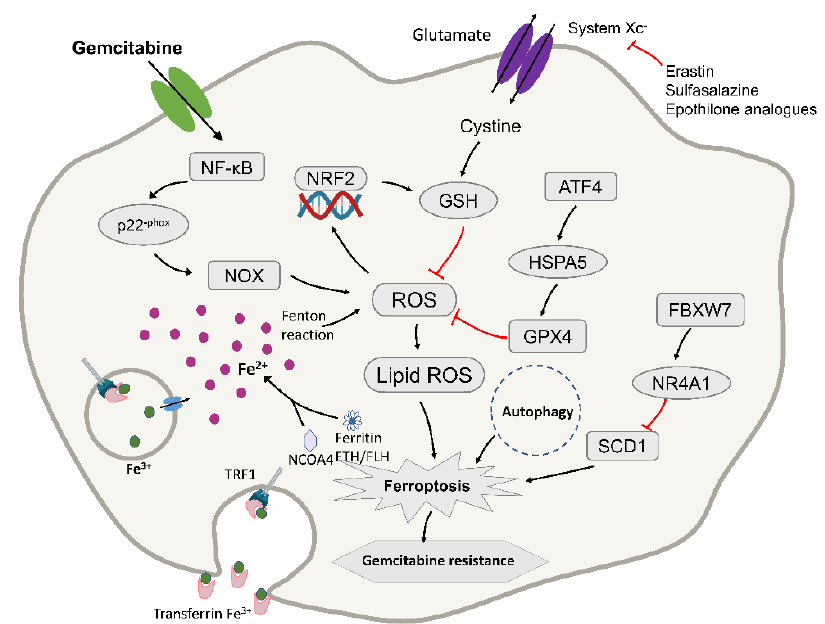
Figure 3. Diagram depicting the molecular targets of ferroptosis and gemcitabine in pancreatic cancer cells. TFR1, transferrin receptor 1; NRF2, nuclear factor erythroid 2-related factor 2; ROS, reactive oxygen species; GPX4, glutathione peroxidase-4; FtH/FtL, ferritin heavy chain/ferritin light chain; NCOA4, nuclear receptor coactivator 4. ATF4, activating transcription factor 4; HSPA5, Heat Shock Protein Family A (Hsp70) Member 5; FBXW7, F-box and WD repeat domain-containing 7; NR4A1, receptor subfamily 4 group A member 1; SCD1, stearoyl-CoA desaturase. ROS accumulation results in the activation of NRF2 and an increase in cellular GSH levels, contributing to intrinsic resistance in PDAC. It may to fight pancreatic cancer cells by inducing ferroptosis. The red lines mean that the expression of upstream molecules can inhibit the progress of downstream molecules.